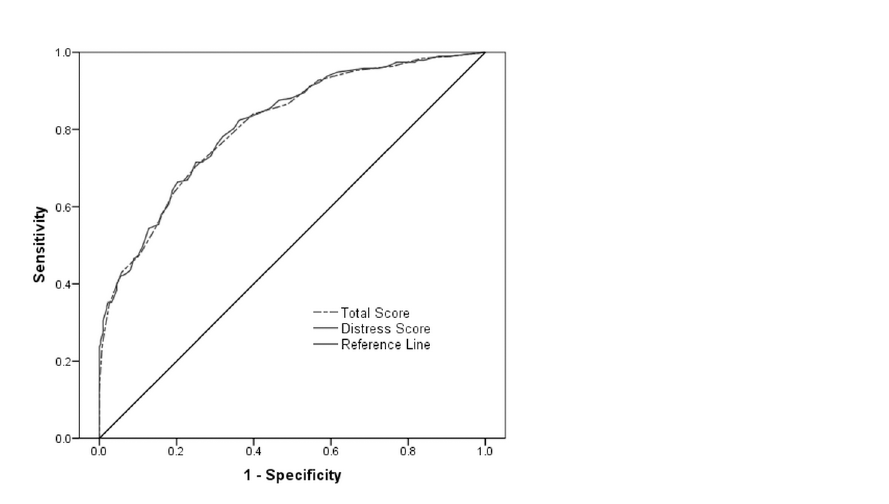
Fig 1. ROC curve: PQ-B total and distress score predicting prodromal/psychotic syndrome vs. no diagnosis on SIPS.